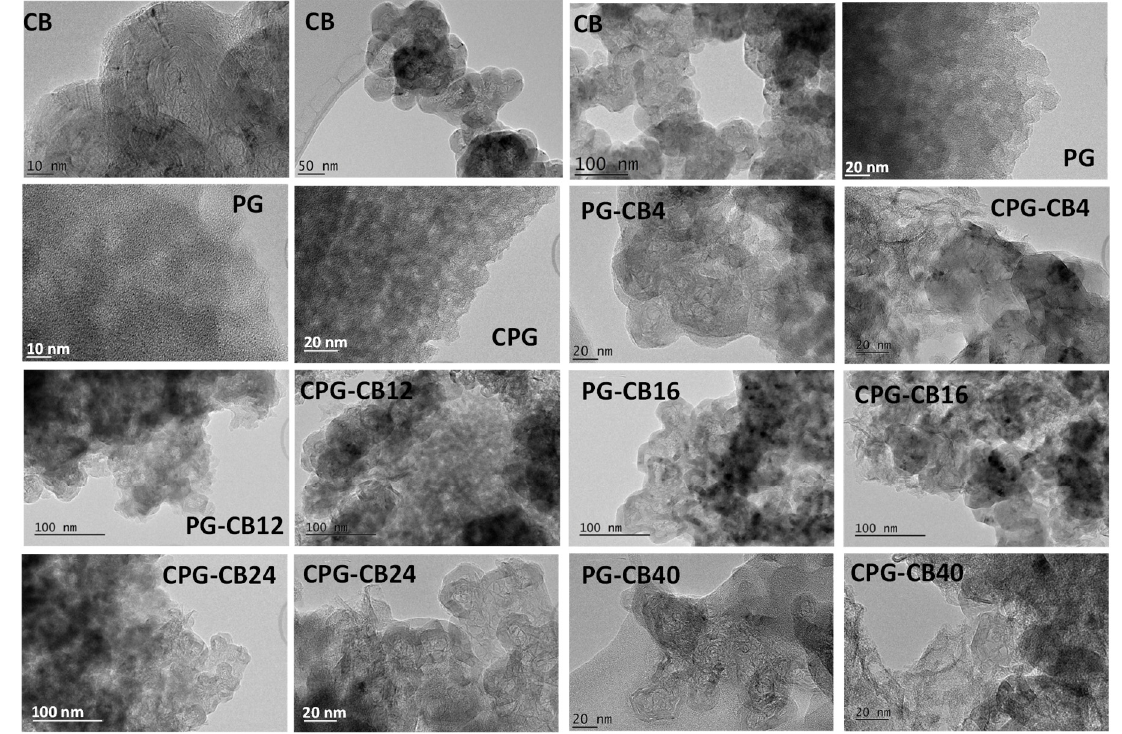
Figure 1. Selected TEM images of the carbon black additive, and the organic (series PG) and carbon gels (series CPG) prepared with different amounts of carbon black. For clarity, images are shown at various magnifications.